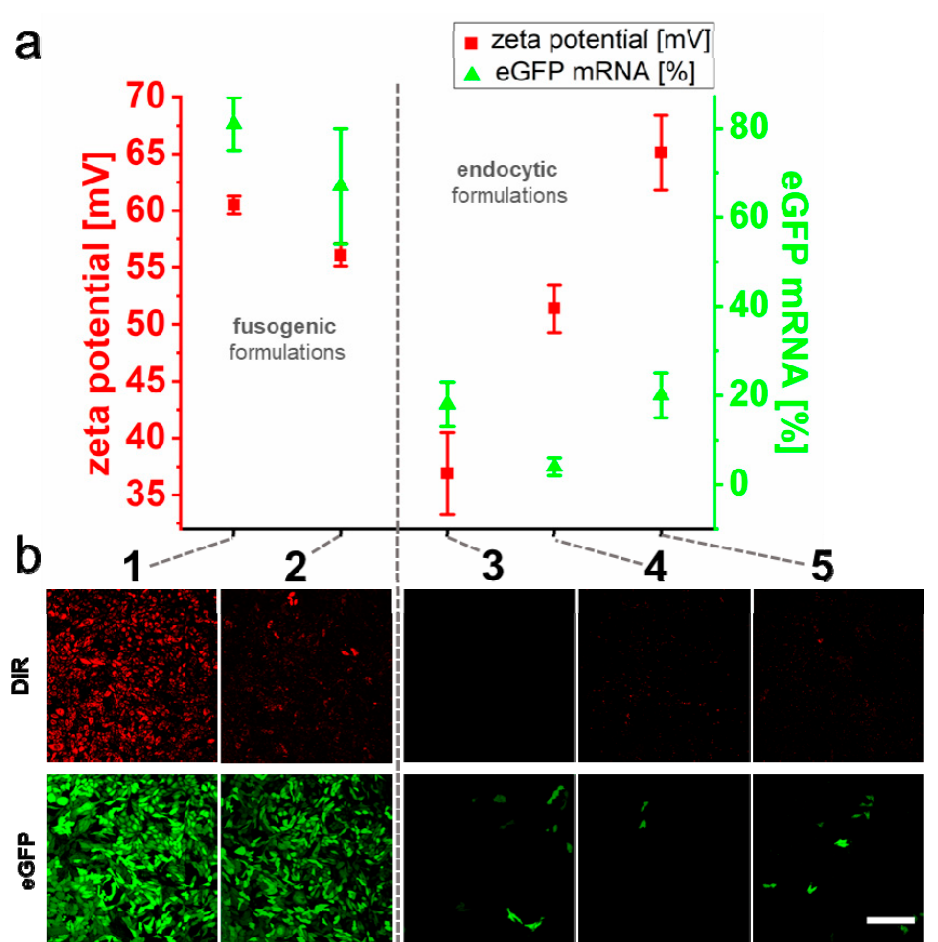
Figure 4. Influence of liposomal formulation on membrane fusion and nucleic acid transfer e ffi ciencies. The liposomal formulations DOPE / DOTAP / DIR (mixing ratio 1 / 1 / 0.1) (1), DOPE / MVL-5 / DIR (1 / 0.2 / 0.1 and 1 / 1 / 0.1) (2 and 5), DOPE / DOTAP (1 / 1) (3), and DOPC / DOTAP / DiR (1 / 1 / 0.1) (4) were used to deliver eGFP–mRNA into CHO cells. Protamine was used as a neutralization reagent. The average zeta potential of liposomes in complex with partially neutralized nucleic acid (see also Table S1) and subsequent eGFP–mRNA transfer e ffi ciency are shown as mean with s.d. of three independent measurements ( a ). Fluorescence micrographs of CHO cells 24 h after treatment with the same complexes were recorded to monitor membrane fusion (DiR) and eGFP transfer e ffi ciencies (eGFP), respectively ( b ). Scale bar 200 µ